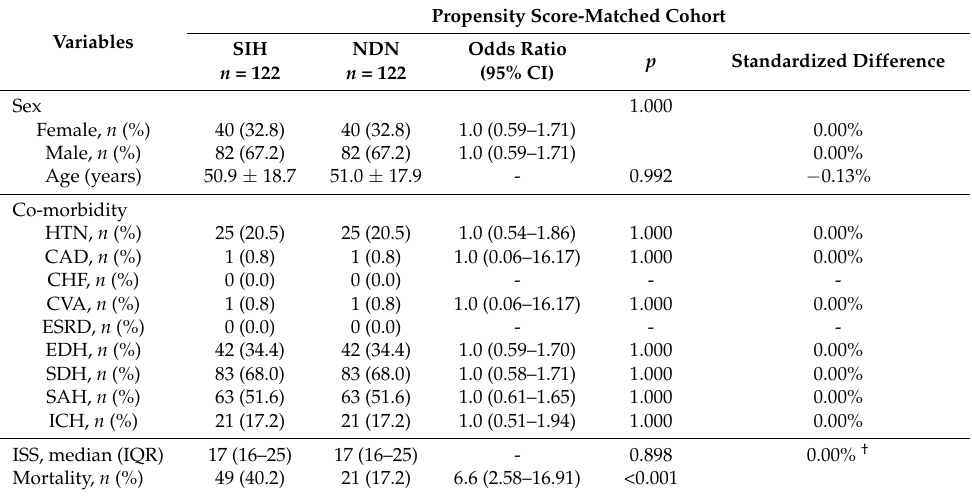
Table 3. Comparison of the mortality outcomes in the selected propensity-score matched cohort of SIH and NDN groups of patients.